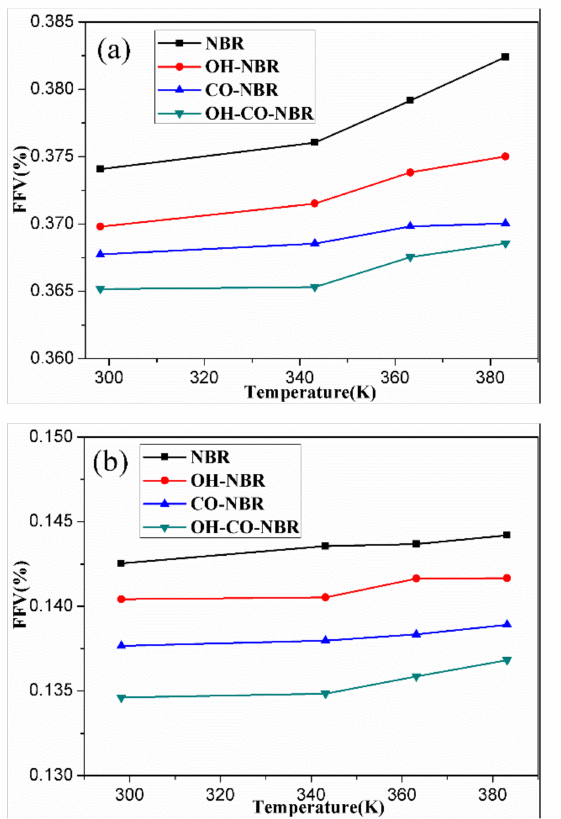
Figure 10. The fractional free volume (FFV) of the unaged and aged NBR models in the uncompressed ( a ) and compressed ( b )